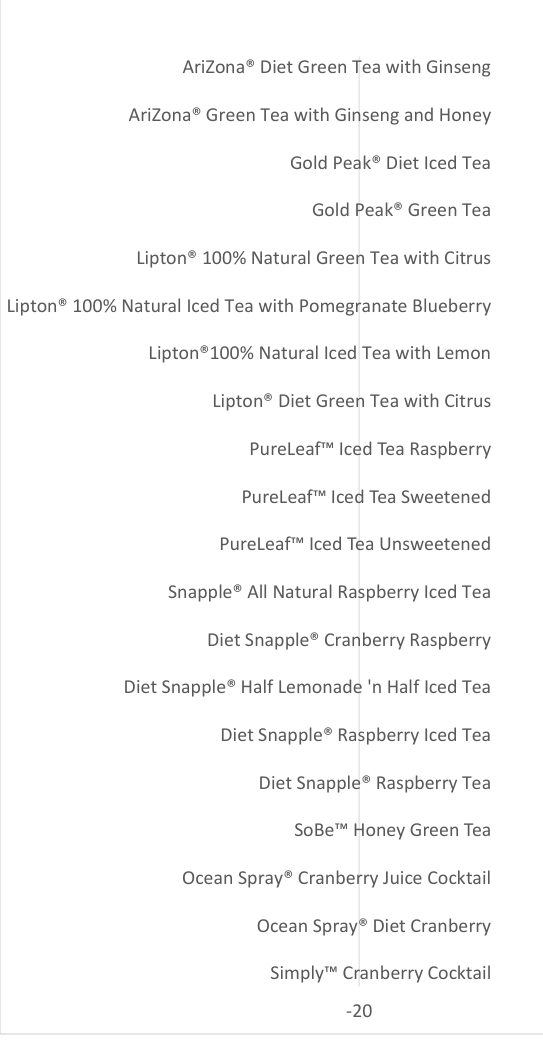
Figure 2. Biofilm formation of S. mutans in the presence of RTD bottled teas and beverages. * Biofilm expressed as % Biofilm formation = OD treated /OD control ×